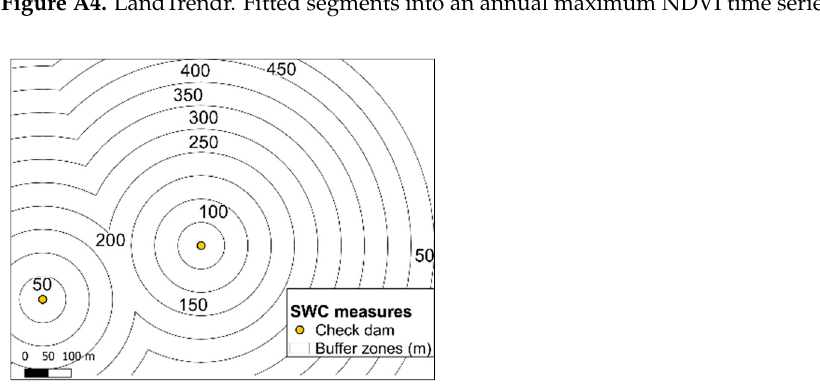
Figure A5. Example of buffer zones used for the OLS regression analysis to examine trends at soil and water conservation measure locations.